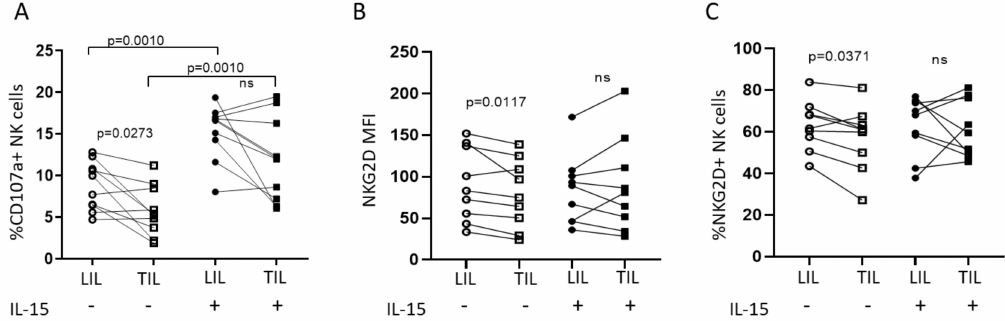
Figure3. IL-15 stimulation inducedNKG2D-mediated degranulation in intrahepatic NKcells. Cytotoxic degranulation (% of CD107a + NK cells) ( A ) was examined in a rADCC assay without (-) and after IL-15 stimulation ( + ) of liver-infiltrating lymphocytes (LIL) ( n = 10) and matched tumor-infiltrating lymphocytes (TIL) ( n = 10). NKG2D expression (Mean Fluorescence Intensity, MFI) ( B ) and NKG2D + NK cell frequency (% NKG2D + NK cells) ( C ) were measured in the same conditions in NK-LIL ( n = 9) and matched NK-TIL ( n = 9). The Mann–Whitney U test or Wilcoxon matched-pairs signed rank test were used to compare data; ns = not significant.